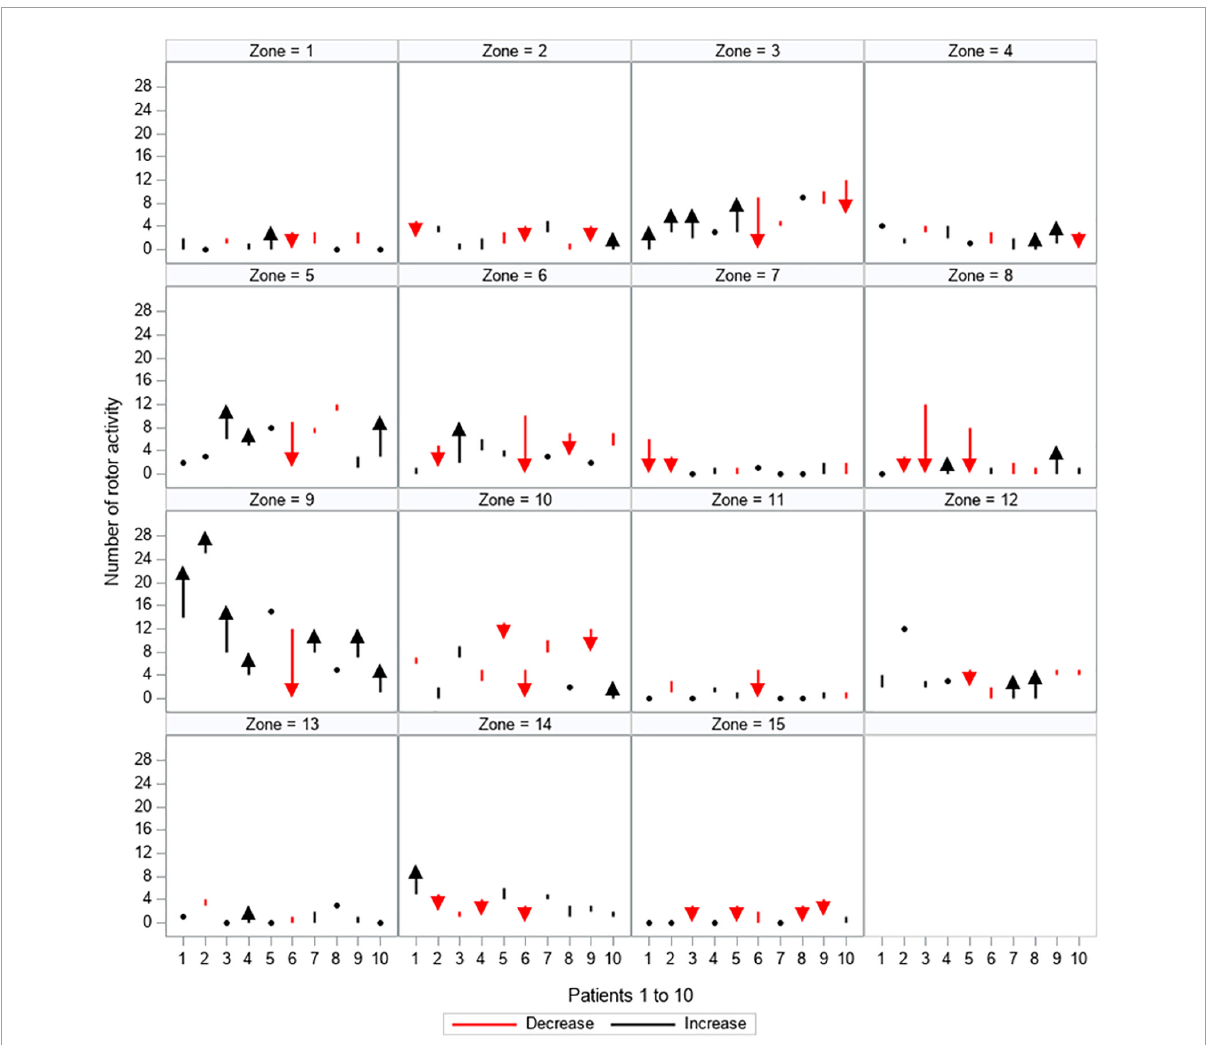
FIGURE6 Quantitative changes in rotor activity. All 15 zones are depicted separately, showing the load of rotor activity (y-axis) for every patient (patients 1–10 are displayed on the x-axis). The dynamic between the first and second mapping is shown: red arrows and lines represent a decrease in the amount of rotor activity, black arrows and lines represent an increase in the amount of rotor activity, black dots represent no change between the first and second